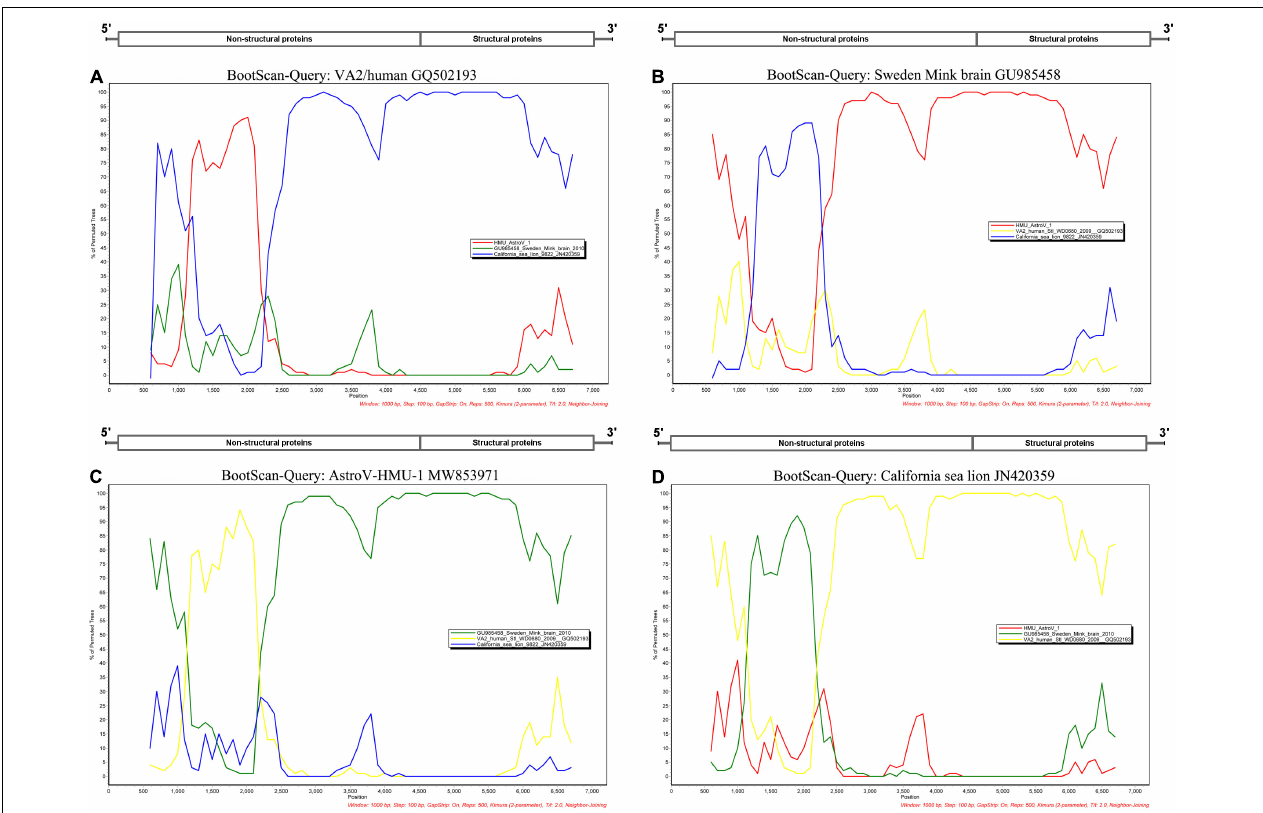
FIGURE 5 | Bootscan analyses based on nearly full-length genomes of AstroV-HMU-1 and Swedish mink brain (GU985458), human VA2/human (GQ502193), and Californian sea lion (JN420359) strains. (A) VA2/human strain used as query sequence in analyses. (B) Swedish mink brain strain used as query sequence in analyses. (C) AstroV-HMU-1 strain used as query sequence in analyses. (D) Californian sea lion strains used as query sequence in analyses. Sliding window of 1,000 nt moving in 100-nucleotide